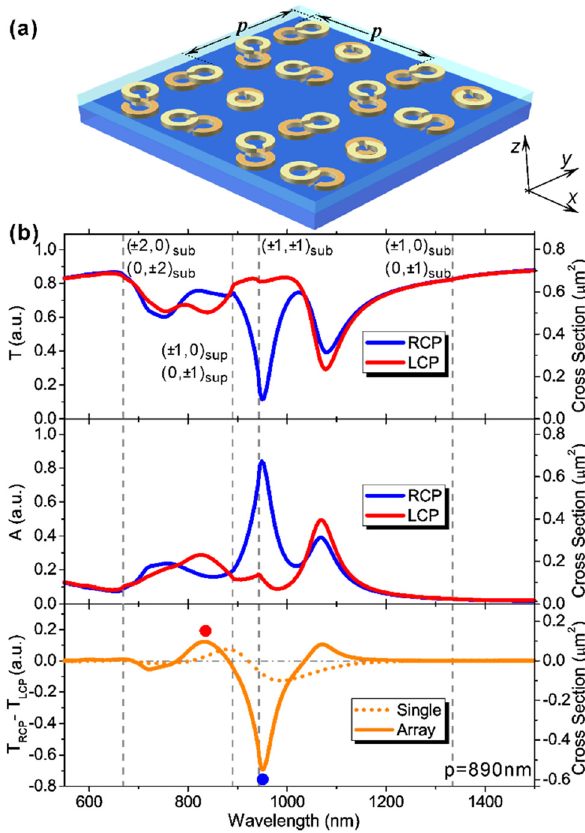
Figure 3: CD responses of a stereo-SRR dimer array organized in C 4 symmetry.(a)Schematicviewsofthestereo-SRRdimerarray.(b)The transmission (upper panel) and absorption (middle panel) spectra with RCP (blue lines) and LCP (red lines) incidences, and the corresponding CD in transmission of the array (solid line, lower panel). The dotted line in lower panel is calculated from equation Δ T = 4 × Δ Abs/ p 2 , which is the ensemble average of CD response calculated by neglecting the coupling between dimers. The vertical dashed lines denote the spectral positions of corresponding RAs, and the tick labels on the right side represent the converted cross section values by multiplying the area of the unit cell ( p 2